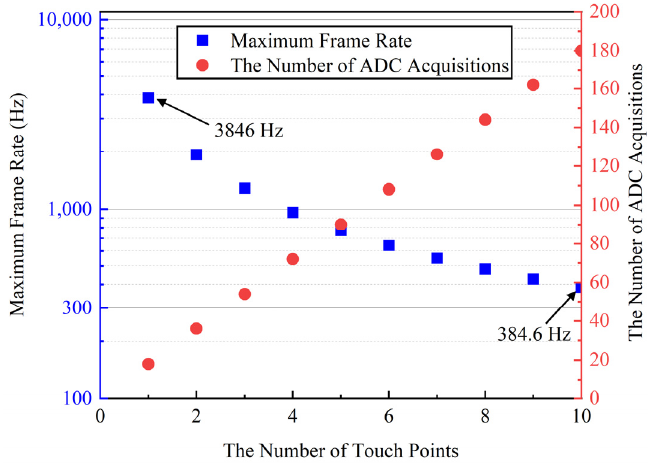
Figure 15. The maximum frame rate and number of ADC acquisitions varies with a different number of touch points.